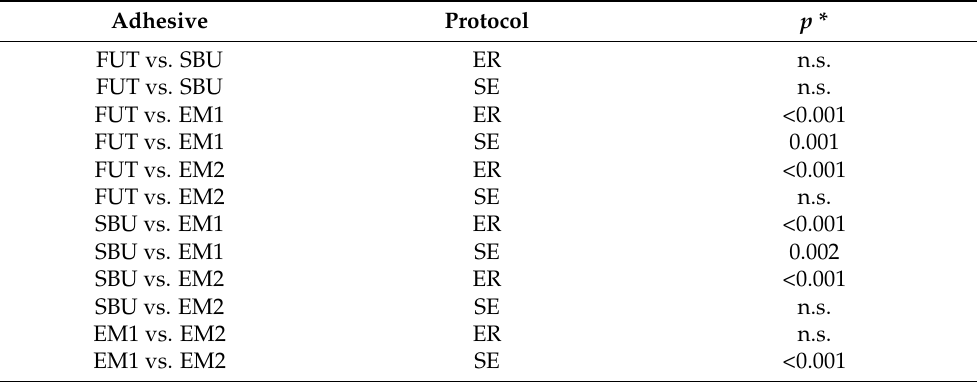
Table 9. Planned contrast results for all variables, indicating statistically significant